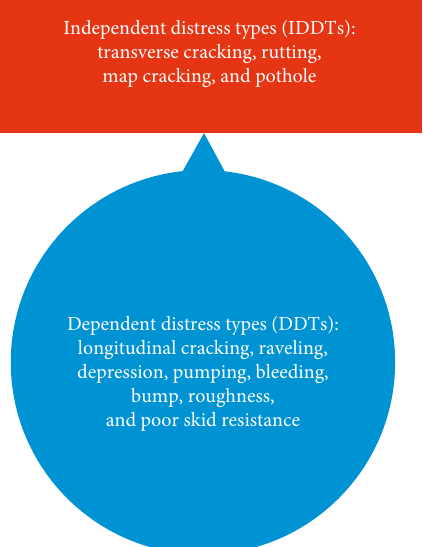
Figure 5: Preliminary distress-type system of asphalt